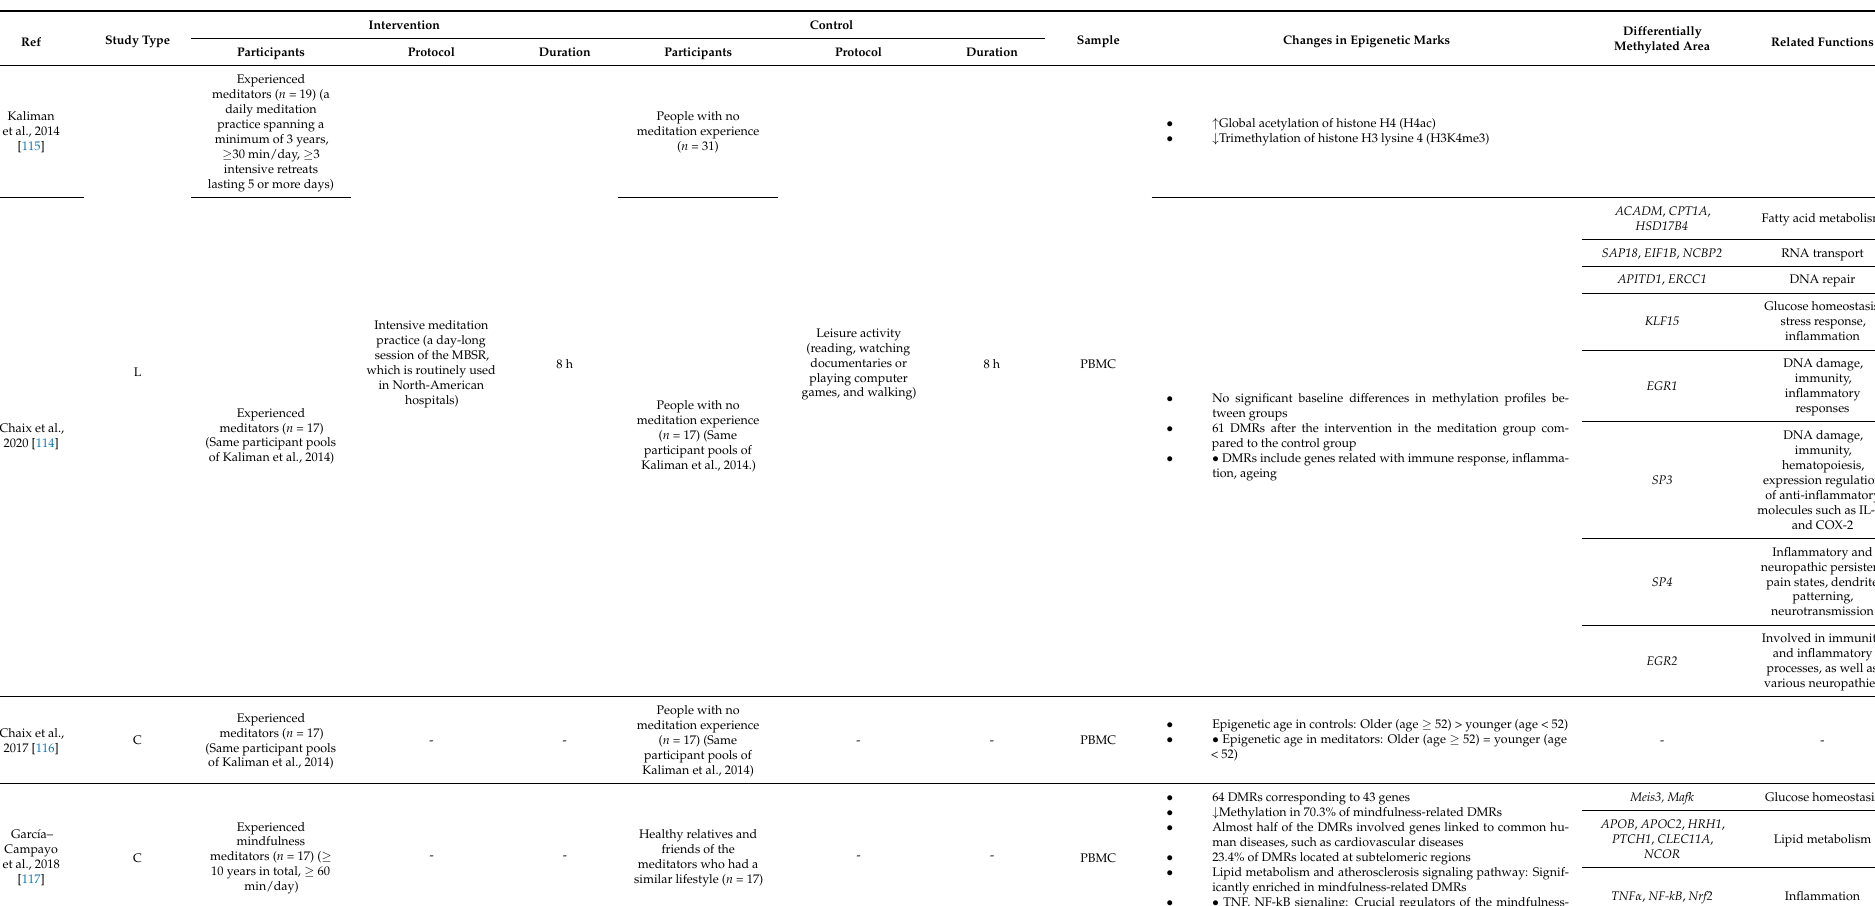
Table 2. Changes in epigenetic marks related to mind–body